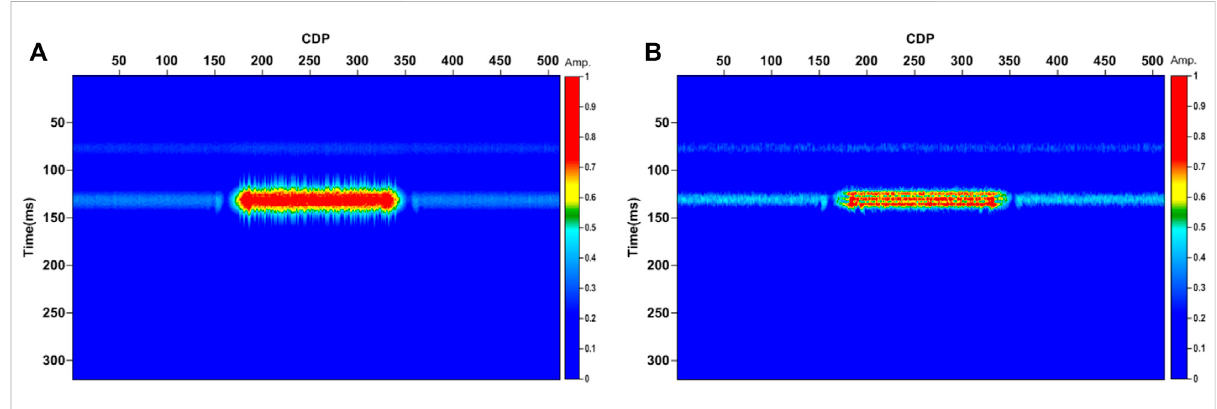
FIGURE 6 Theabsorptiongradientsectionofthenoisydata inFigure1Bestimatedby (A) VMDandLSFappliedatthehigh-frequencysegment,and (B) the proposed